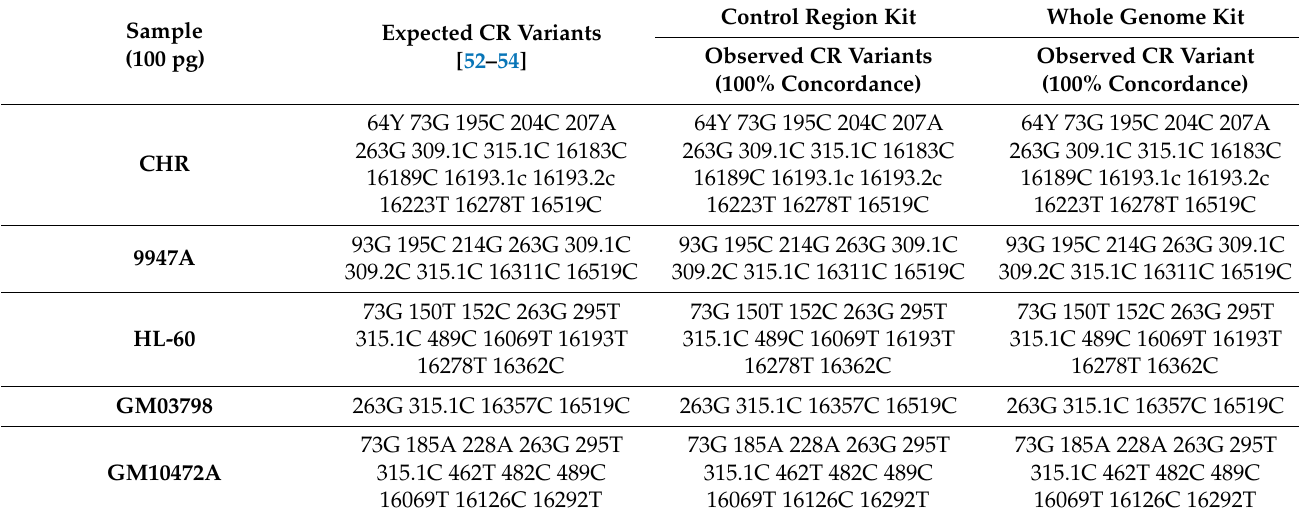
Table 5. mtDNA control region concordance studies: control region multiplex vs. whole mtGenome multiplex in five well-characterized DNA